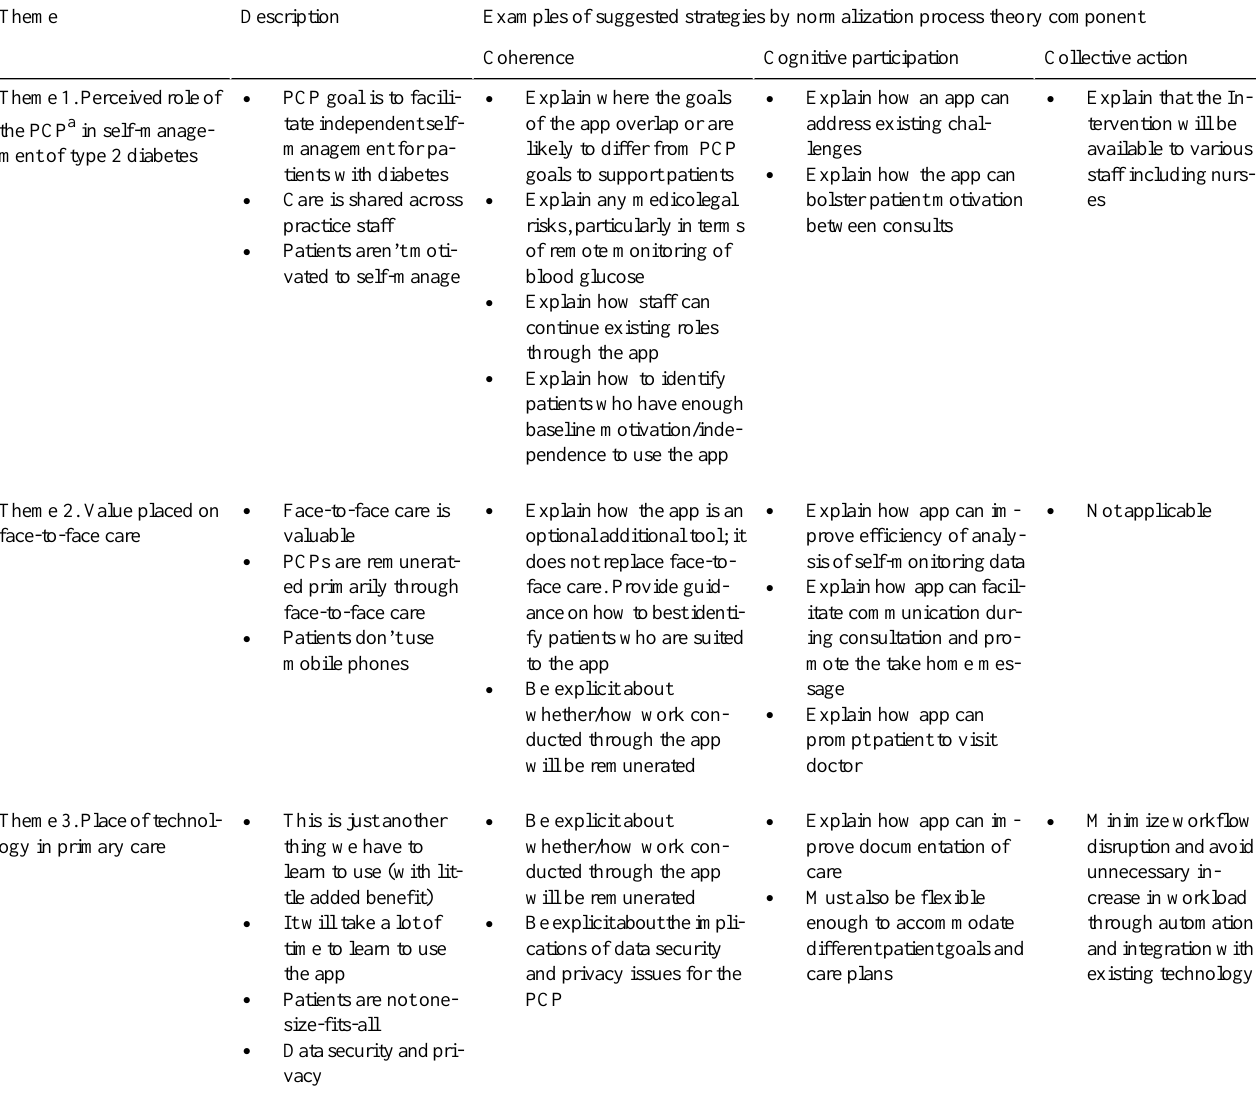
Table 2. Summary of themes and how suggested strategies relate to normalization process